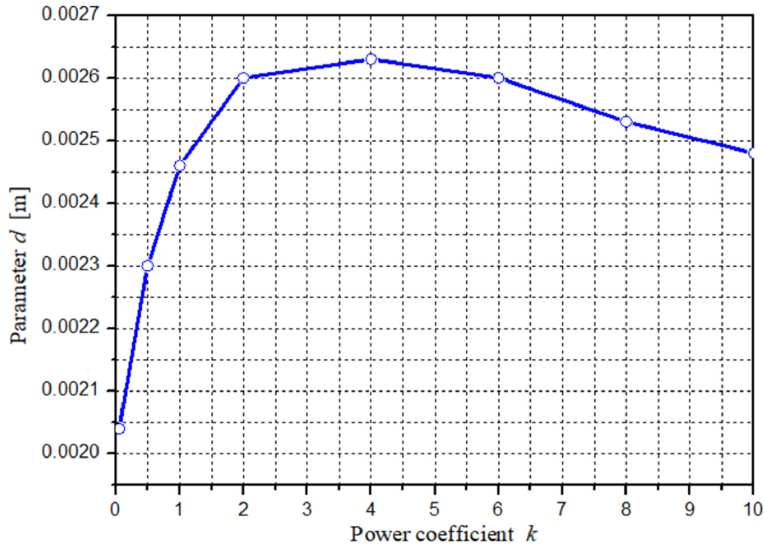
Figure 20. Parameter d of the neutral plane positioning versus power coefficient k.